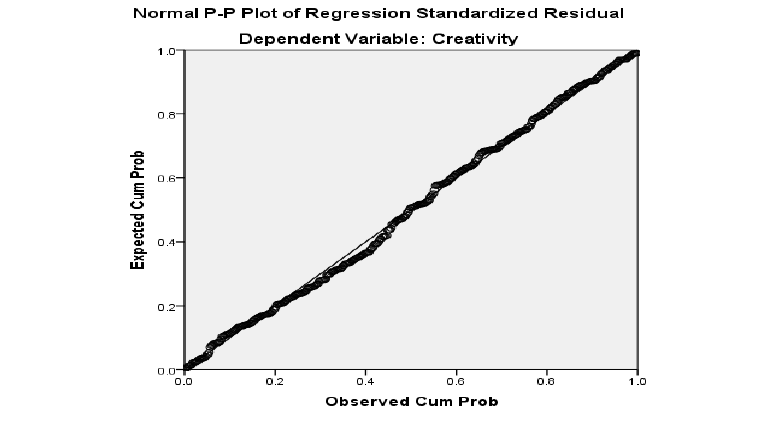
Figure 1: Normal P-P Plots